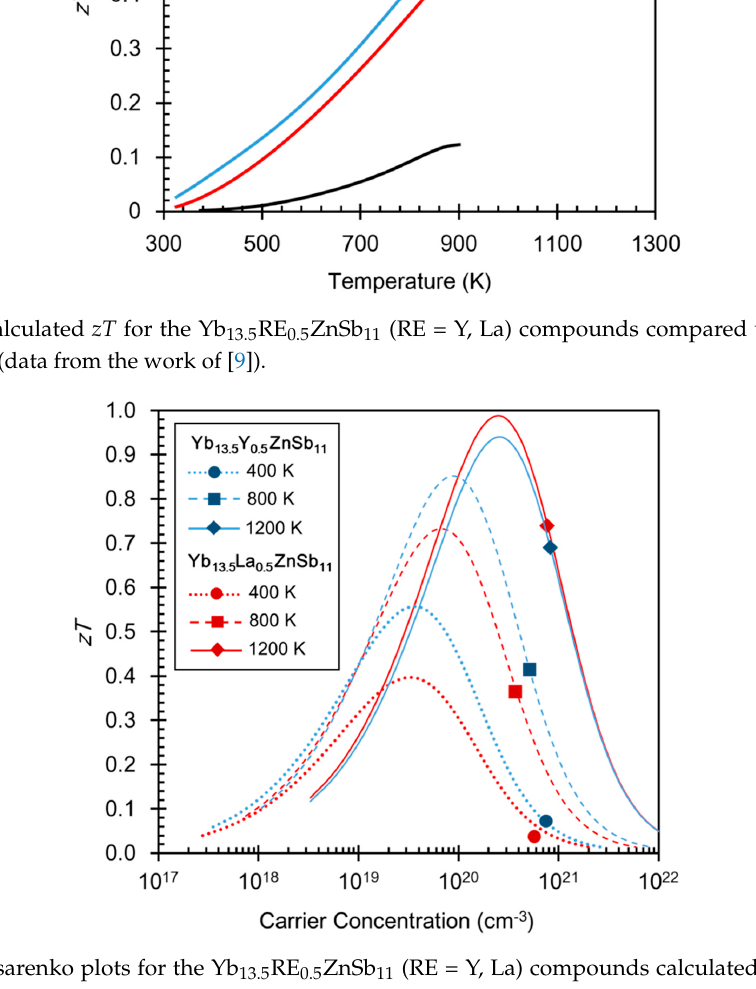
Figure 6. Calculated zT for the Yb 13.5 RE 0.5 ZnSb 11 (RE = Y, La) compounds compared with that of Yb 14 ZnSb 11 (data from the work of [9]).